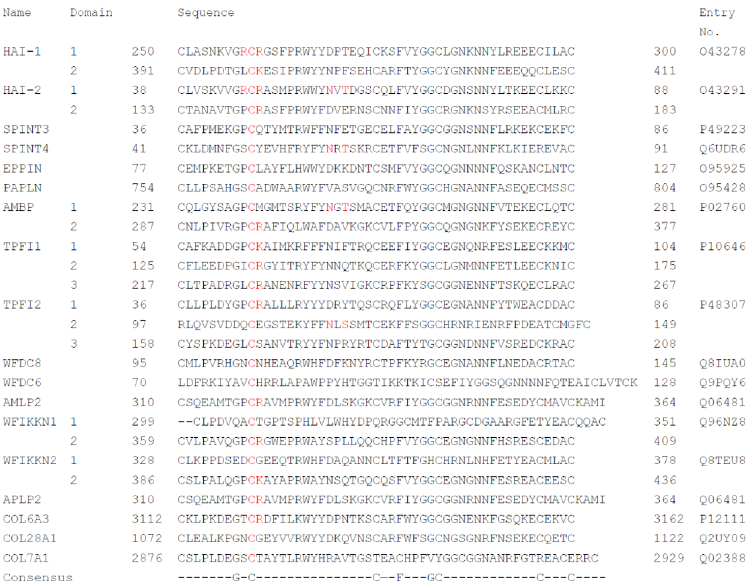
Fig 7. Alignment and comparison of the amino acid sequence of 27 Kunitz domains from 18 human proteins. The amino acid sequences of 27 Kunitz domains from 18 human proteins, including HAI-1, HAI-2, and bikunin (Alpha-1-microglobulin/bikunin precursor, AMBP) are compared. The P1 sites with Arg and Lys, and the P3/P4 sites with Arg, the second Cys residue and the putative N-glycosylation sites in the region corresponding to Asn-57 of HAI-2 are highlighted in red. The amino acid sequences were obtained from Uniprot (http://www.uniprot.org/). The names of these Kunitz proteins are provided on the left with their entry numbers on the